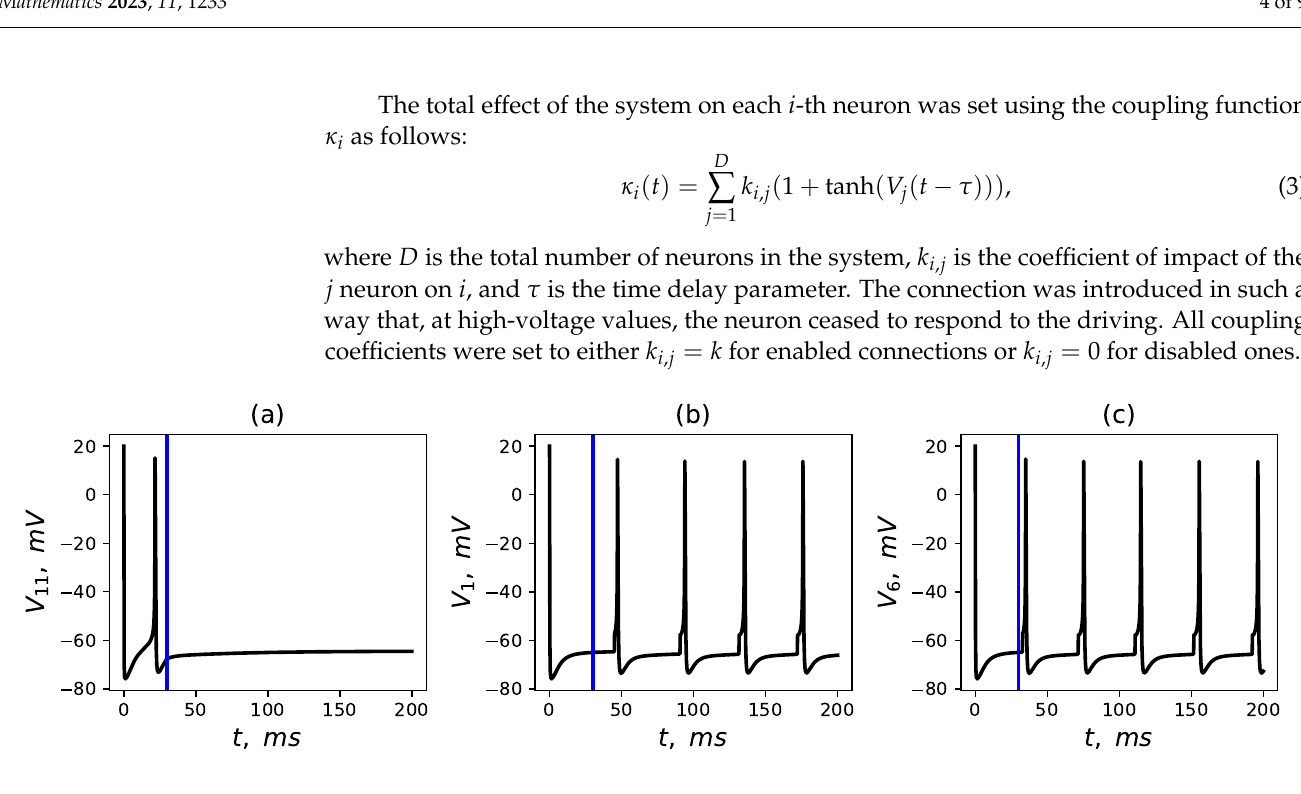
Figure 2. Time series of the transmembrane voltage ( V variable of the model) by D = 10, τ = 0.2 ms and k = 40 for the starter neuron No. 11 ( a ) and for the ring neurons No. 1 ( b ) and No. 6 ( c ). Vertical blue line represents the oscillating time of neuron No.